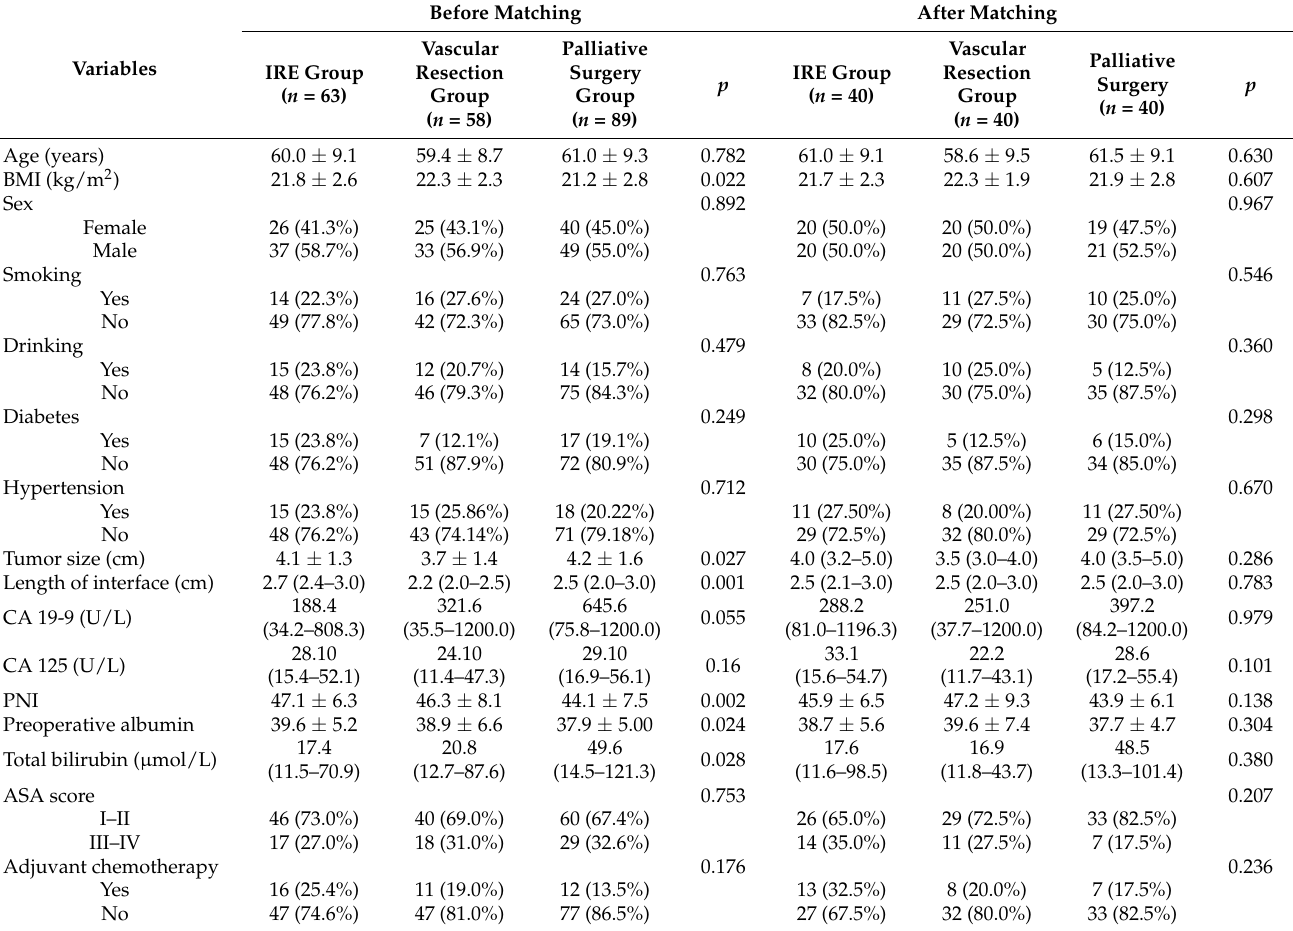
Table A2. Demographics and clinical characteristics of the